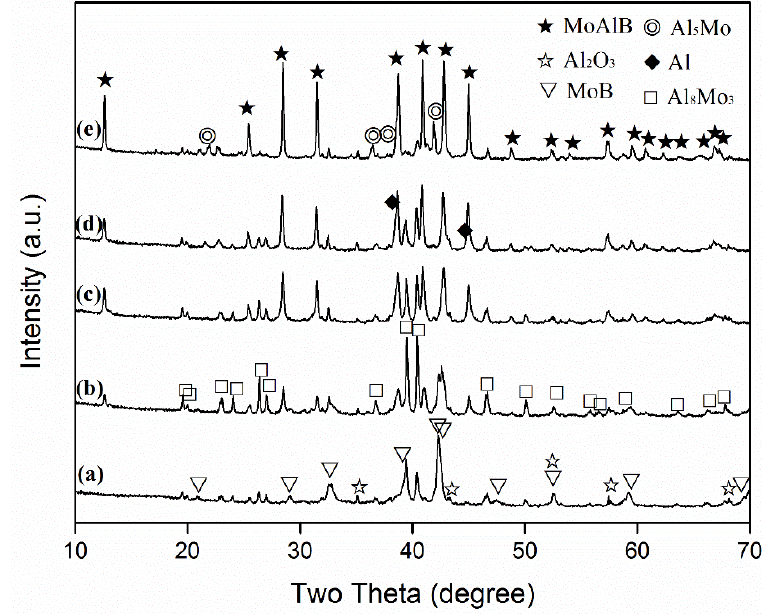
Figure 2. XRD spectra of the samples heated at 850 °C for 6 h, with different amounts of excess Al at ( a ) stoichiometric amount, ( b ) 60%, ( c ) 80%, ( d ) 100% and ( e ) 120%.